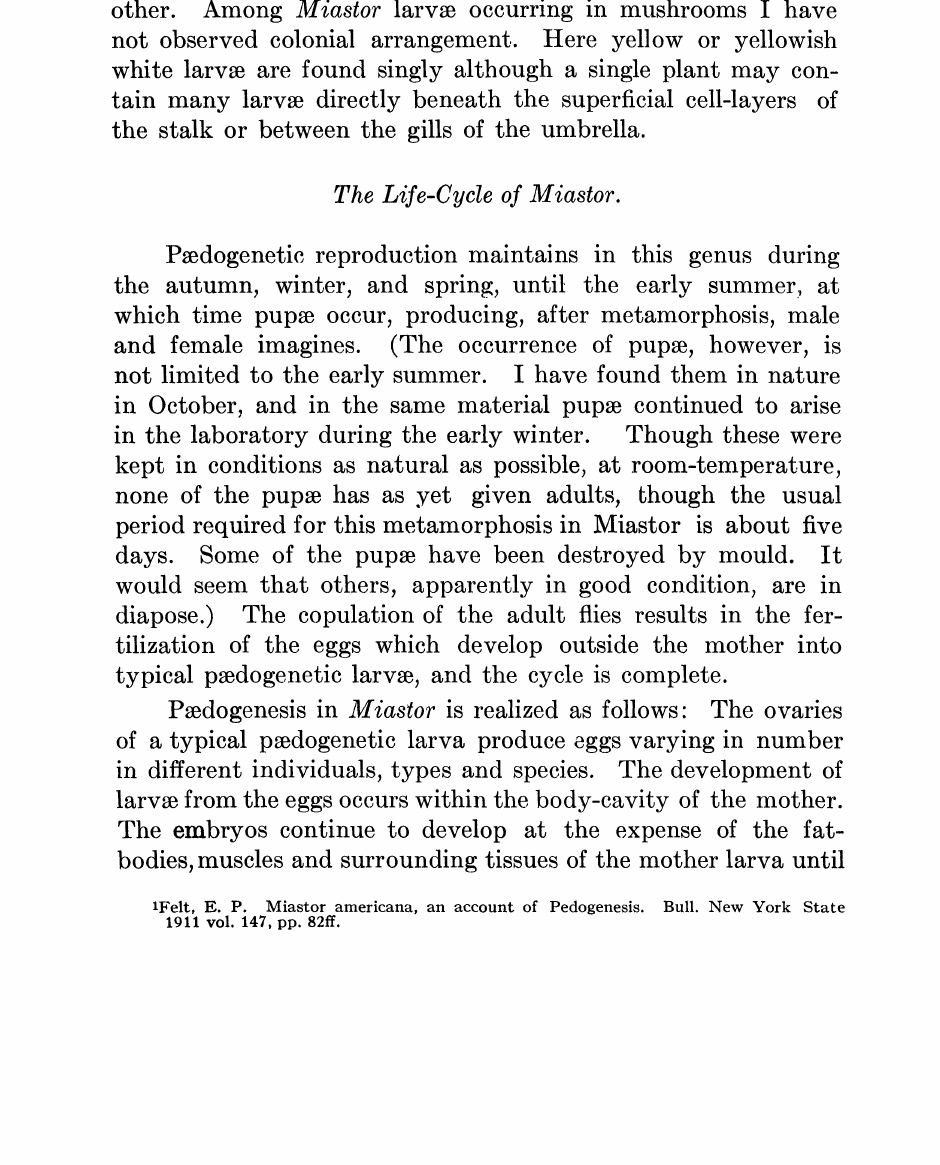
table matter. Their habitat is not limited to Europe. In Amer- ica Felt found Miastor larvae in 1910 under the partially decayed inner bark of chestnut